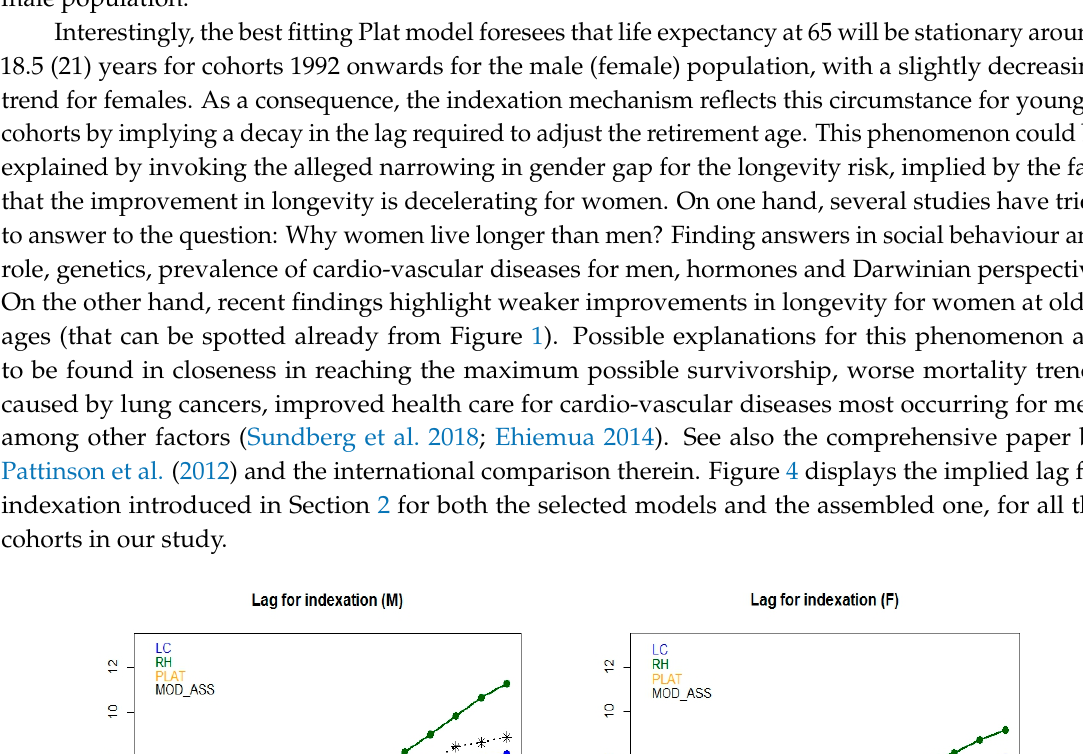
Figure 3. Observed and fitted death rates with forecasts 30 years onwards.